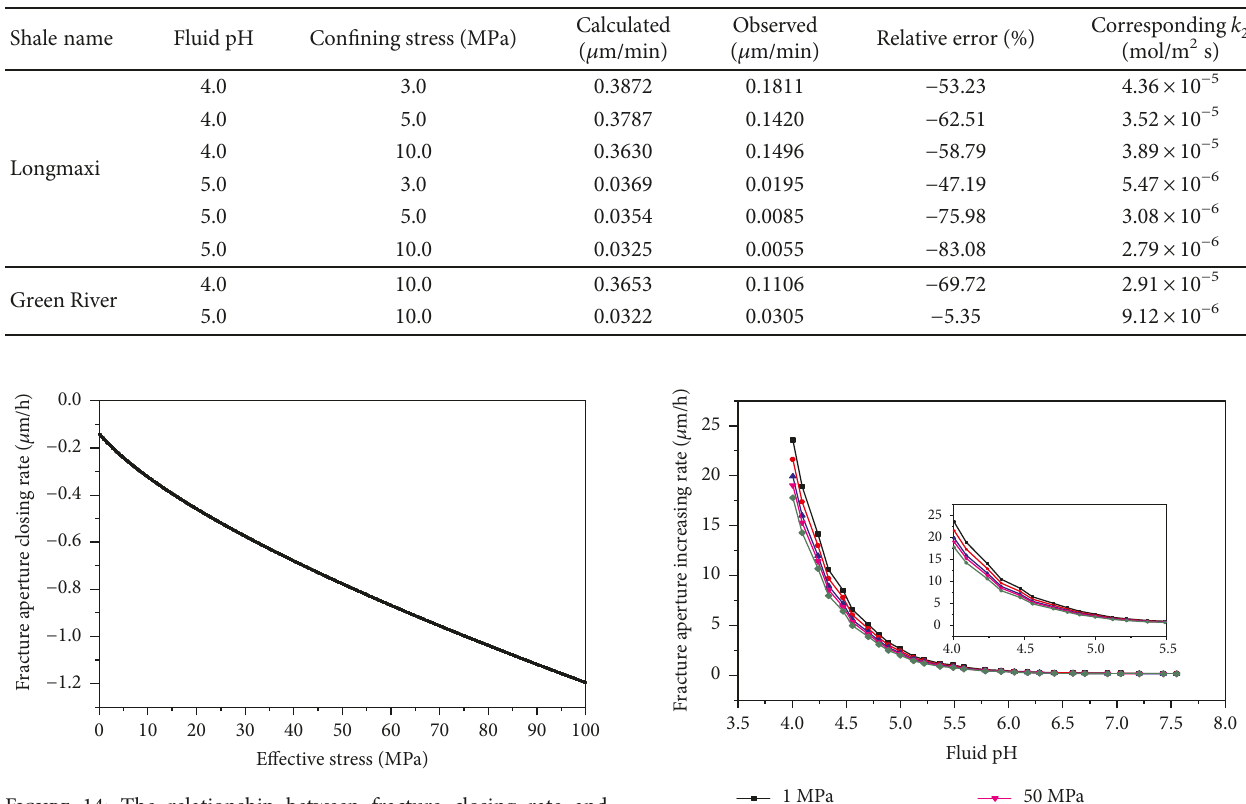
Figure 14: The relationship between fracture closing rate and con fi ning stress.